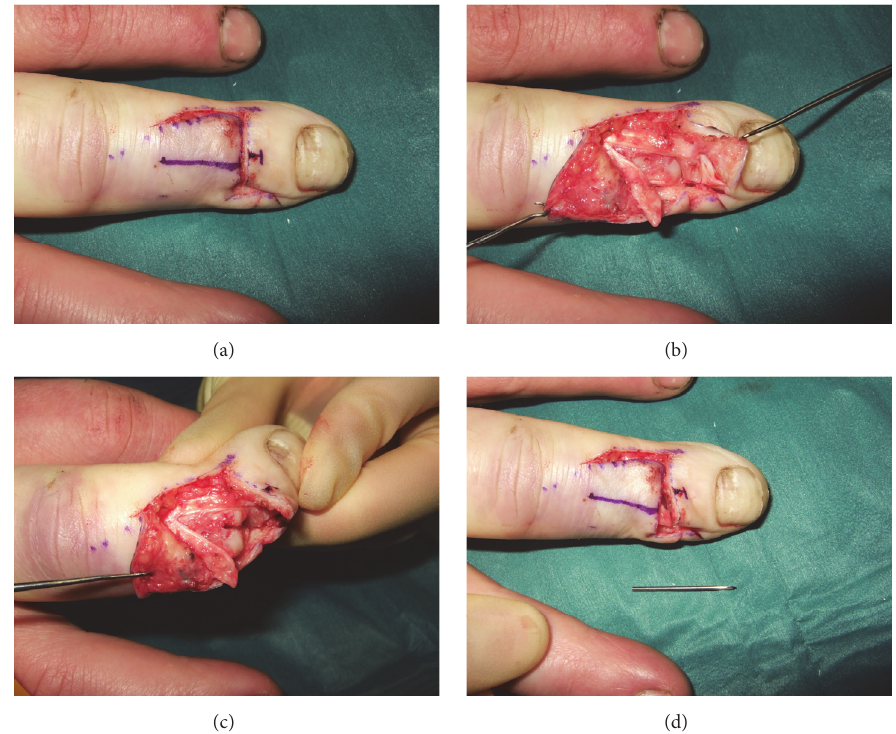
Figure 3: Right middle finger skin incision (a) with central line marking K-wire position based on fluoroscopy. Extensor tendon divided on ulnar side to access distal interphalangeal joint (b). Incision made dorsally on middle phalanx down to K-wire allowing it to be pushed out distally, facilitated by radial deviation at distal interphalangeal joint (c-d).